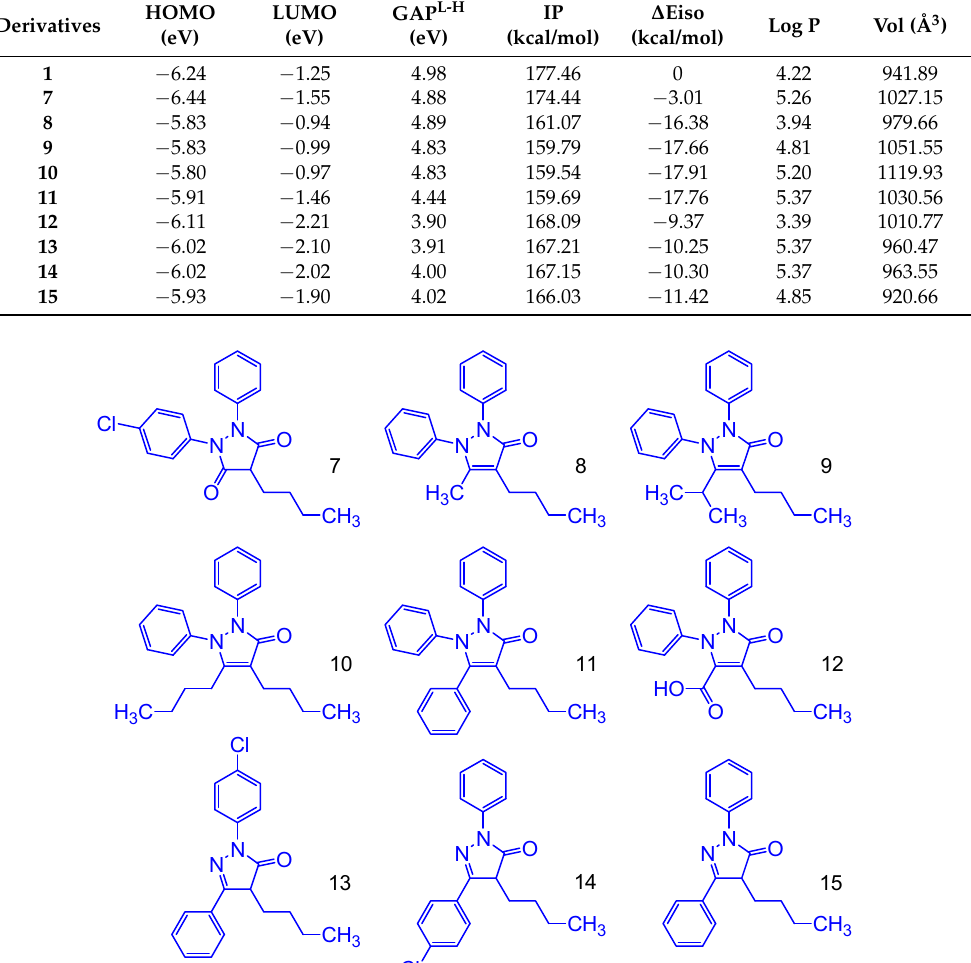
Figure 5. Molecular structure of proposed phenylbutazone derivatives.